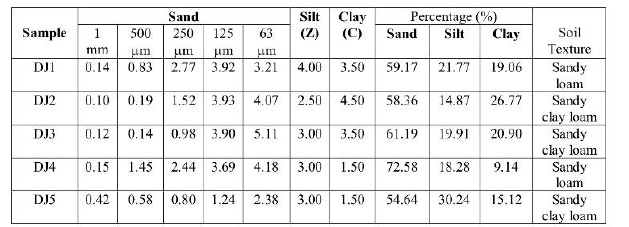
Figure 4: Map of the cutting and filling area, slope location, new ‘natural sediment trap’ and histogram of the soil loss estimation. Table 1: Grain size distribution and soil texture